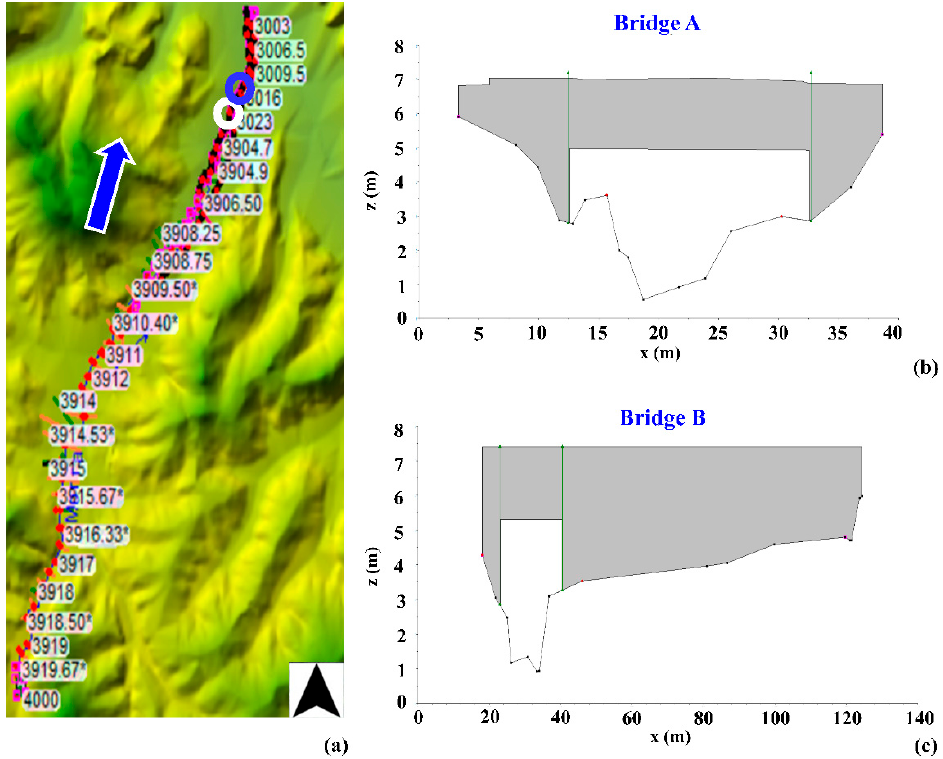
Figure 4. ( a ) Morra Creek HEC-RAS v5.0 geometry model of the 1D unsteady hydraulic simulations for Scenario I. The * in the figure is just due to the software output visualization. Scheme of ( b ) “Bridge A” (white circle in Figure 4a) and ( c ) “Bridge B” (blue circle in Figure 4a) cross-sections adopted in HEC-RAS v5.0 geometry model. The blue arrow indicates the flow direction.